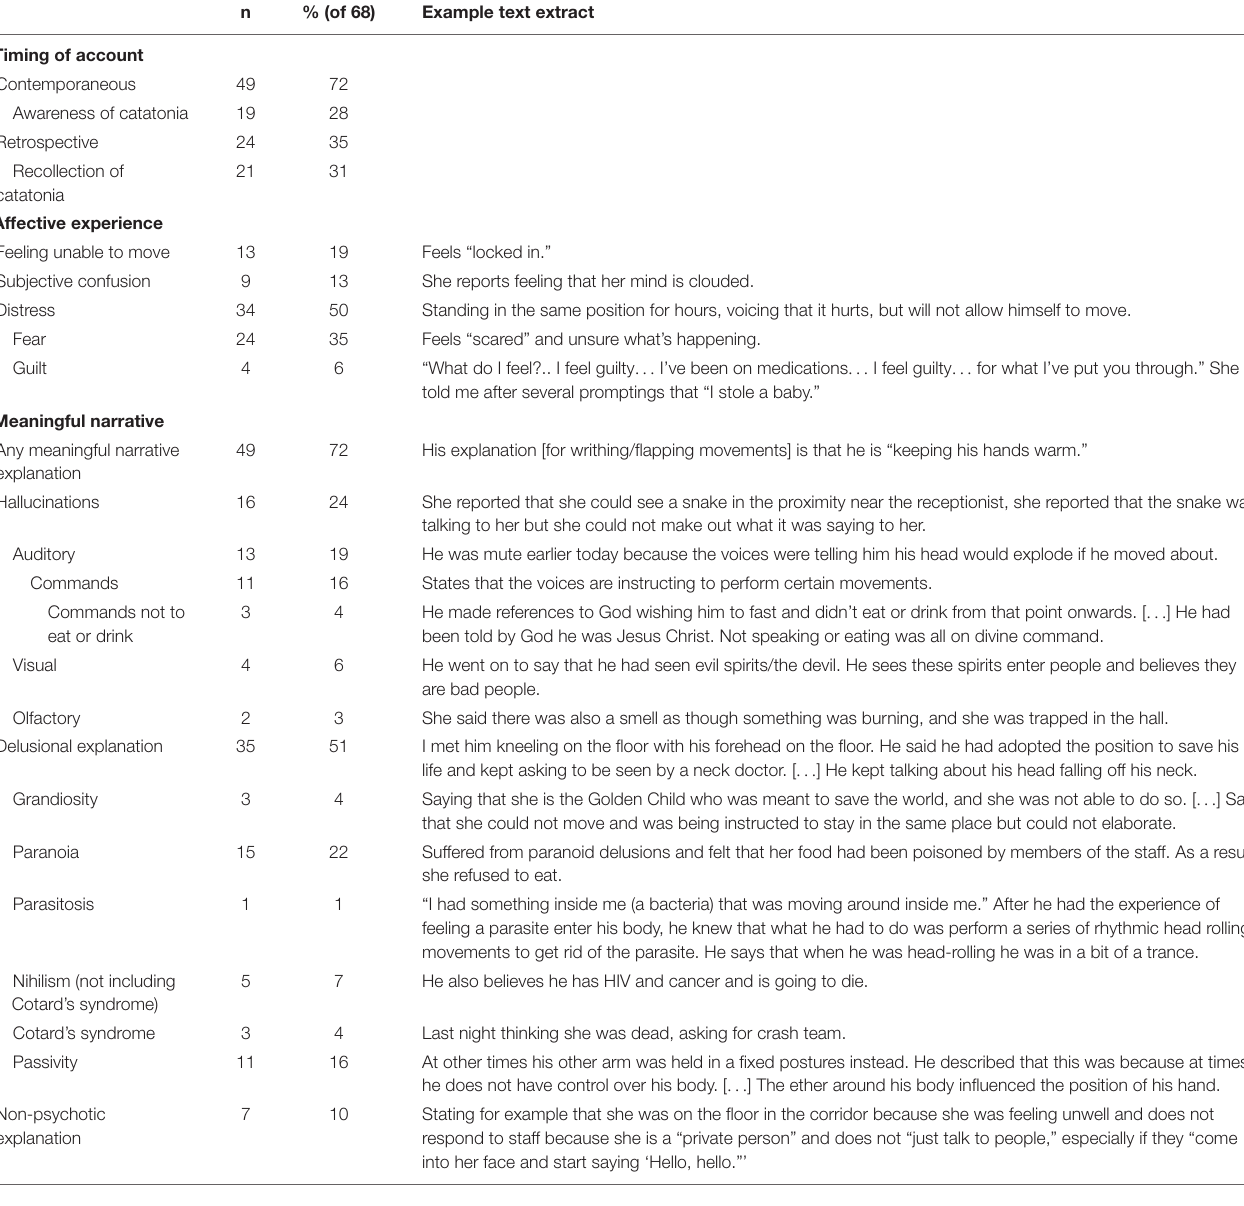
TABLE 5 | Categorisation of subjective experiences of catatonia. n % (of 68) Example text